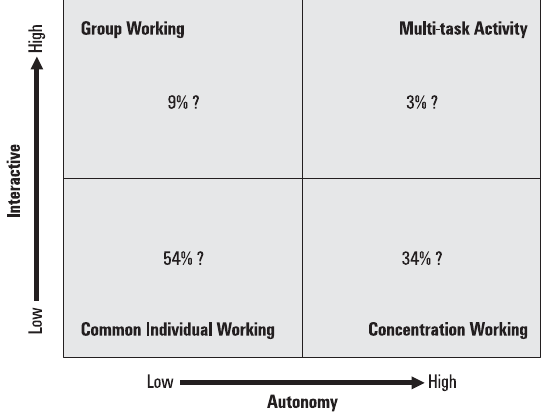
Figure 7. Proportion of activity based working area in traditional layout SLA offi ces